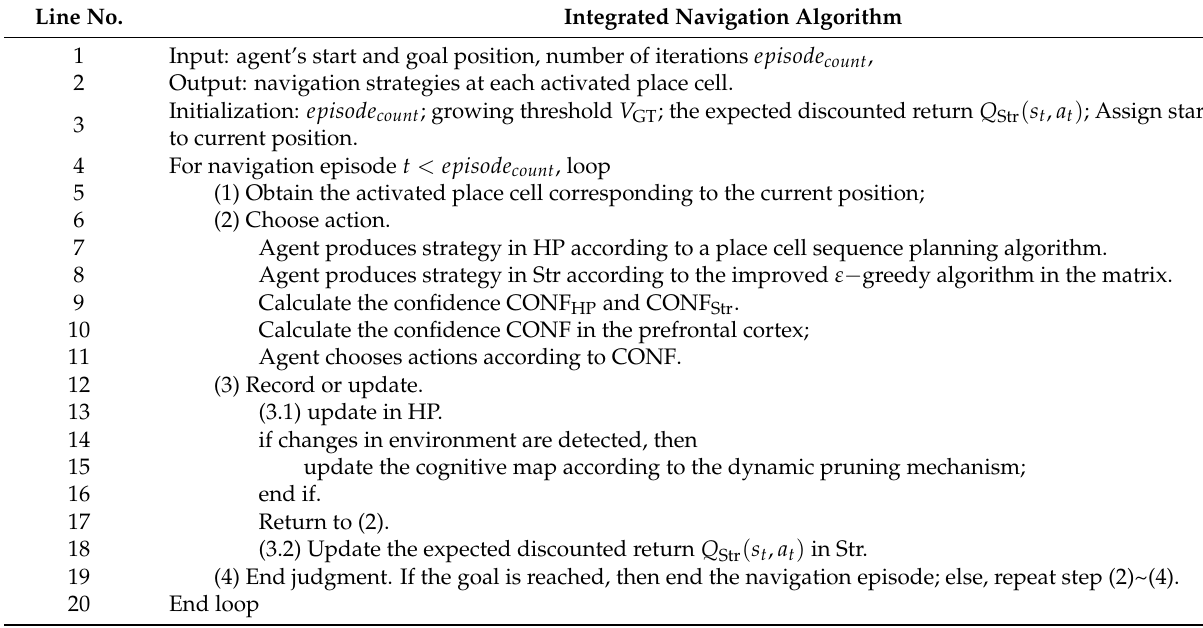
Table 2. Integrated navigation algorithm based on the arbitration mechanism in the prefrontal cortex. Line No. Integrated Navigation